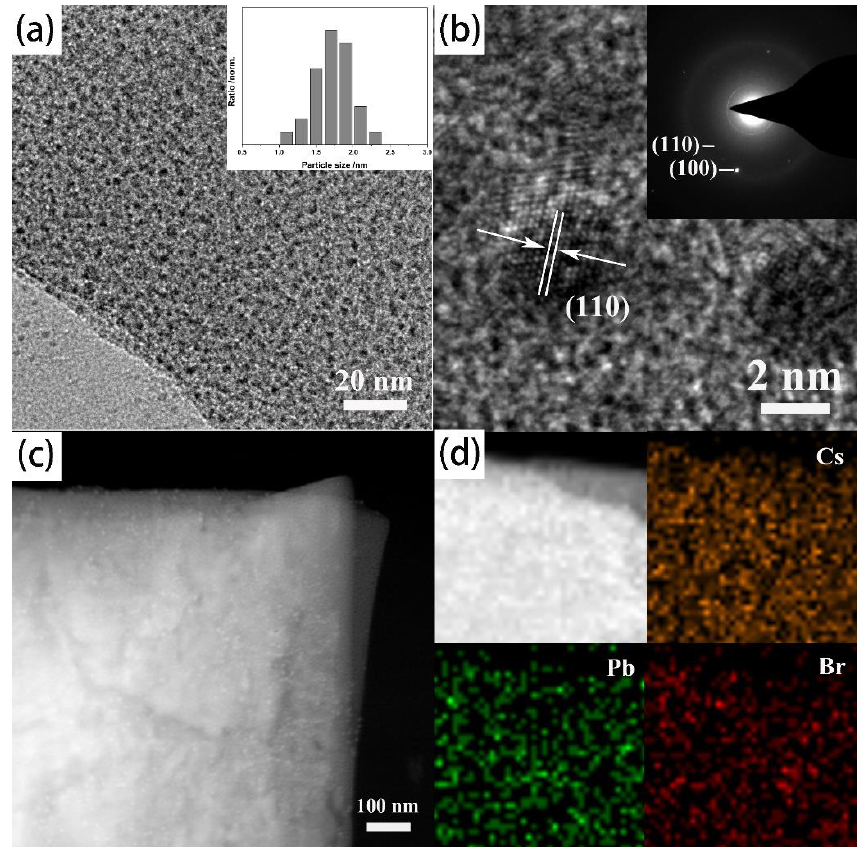
Figure 3. ( a ) The represent TEM image of CsPbBr 3 perovskite quantum dots and narrow size distribution insets of figure. ( b ) The HRTEM and SAED images of CsPbBr 3 @Cu-BDC. ( c ) HAADF-STEM image of CsPbBr 3 quantum dots. ( d ) The elemental mapping images showing the elemental distribution of Cs, Pb, and Br.